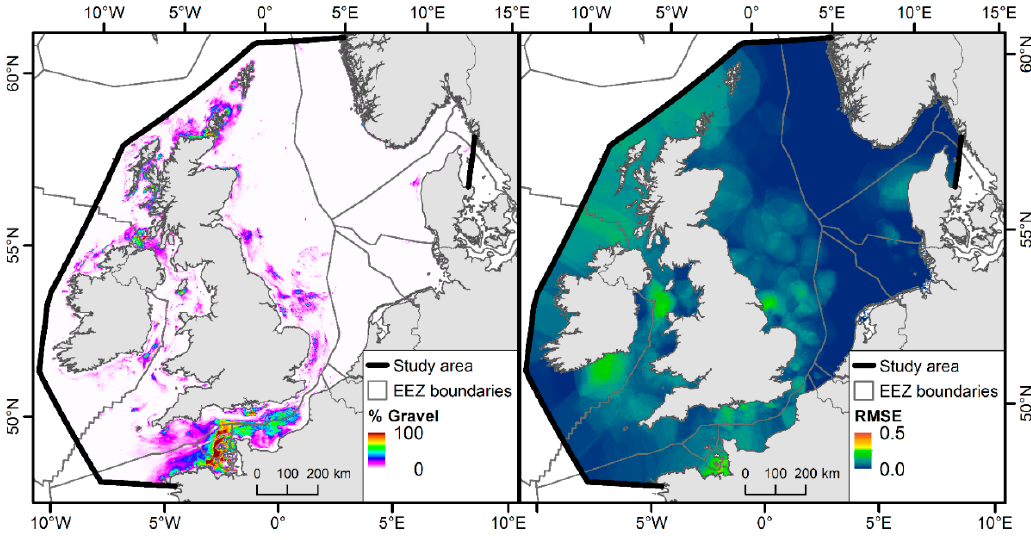
Figure 6. Predicted distribution of gravel and spatial distribution of error, represented as local RMSE.